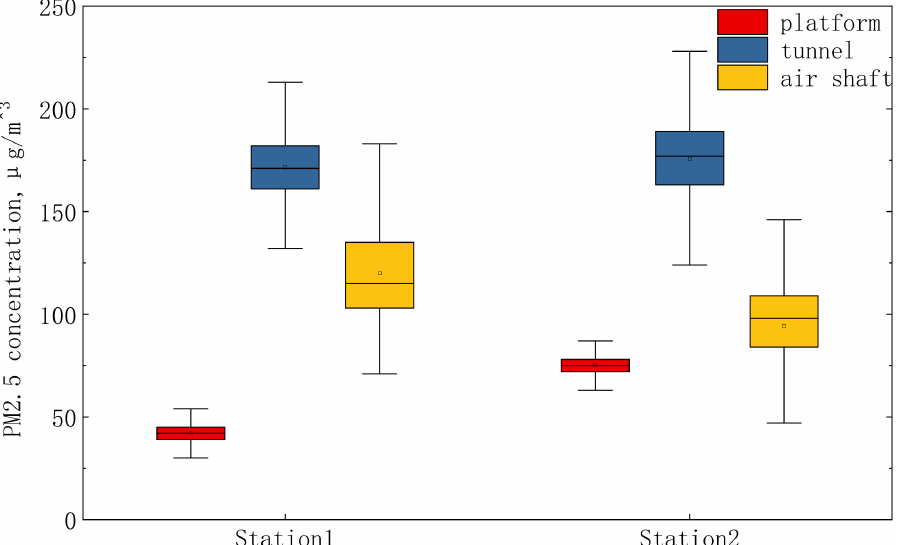
Figure 6. PM2.5 concentration at different